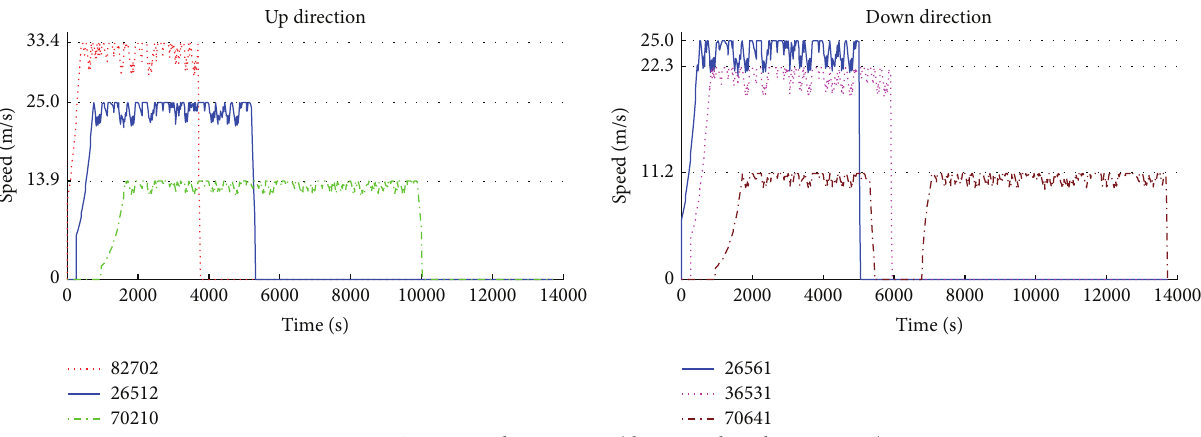
Figure 9: Train speed-time curve (the NCBS length is 30000